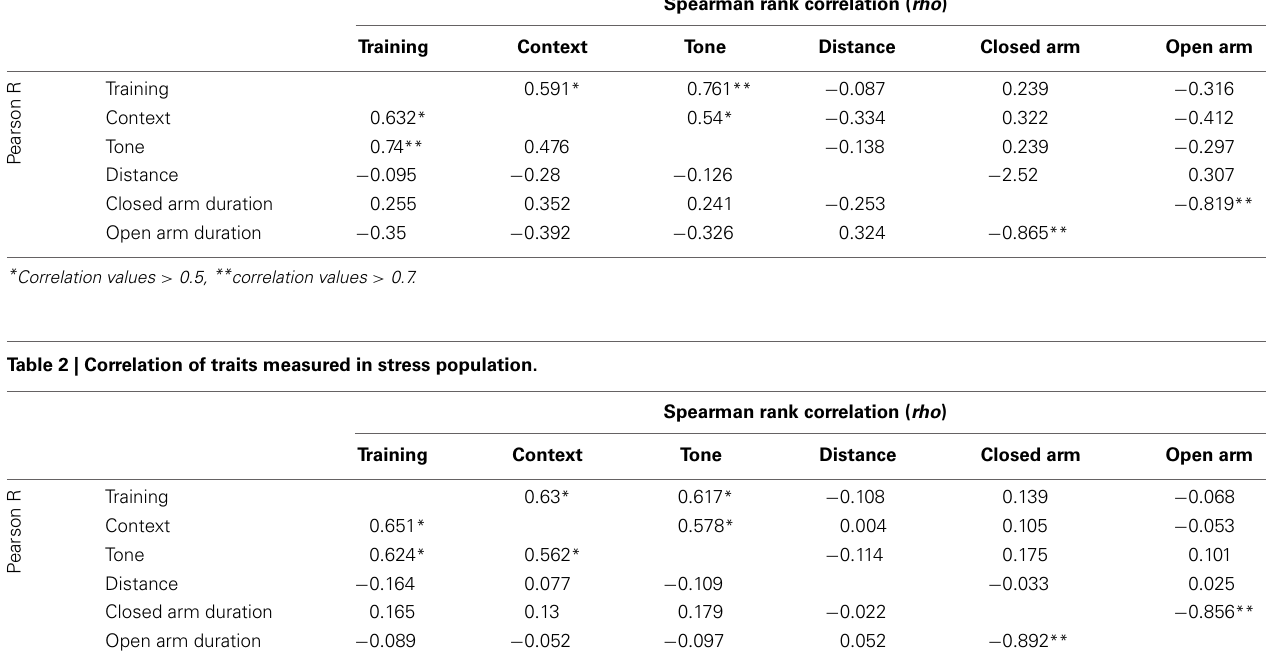
Spearman rank correlation ( rho )